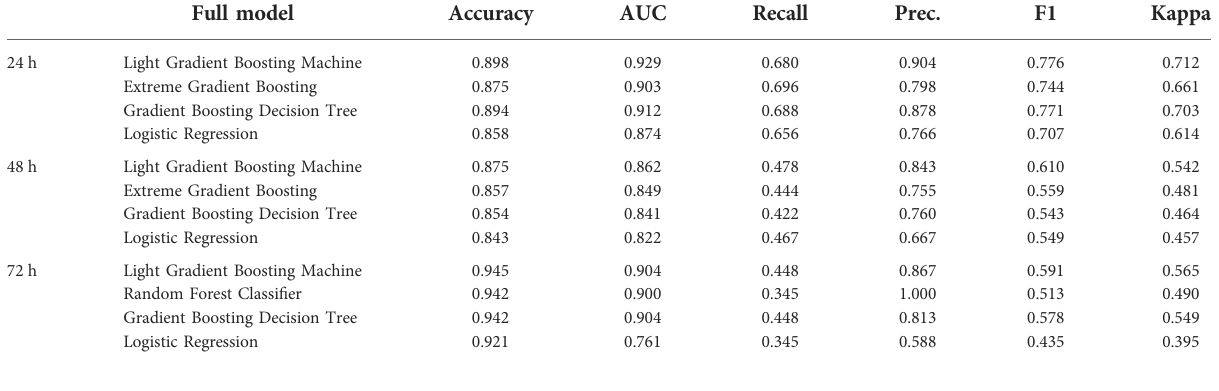
TABLE 2 Performance of full models in the validation